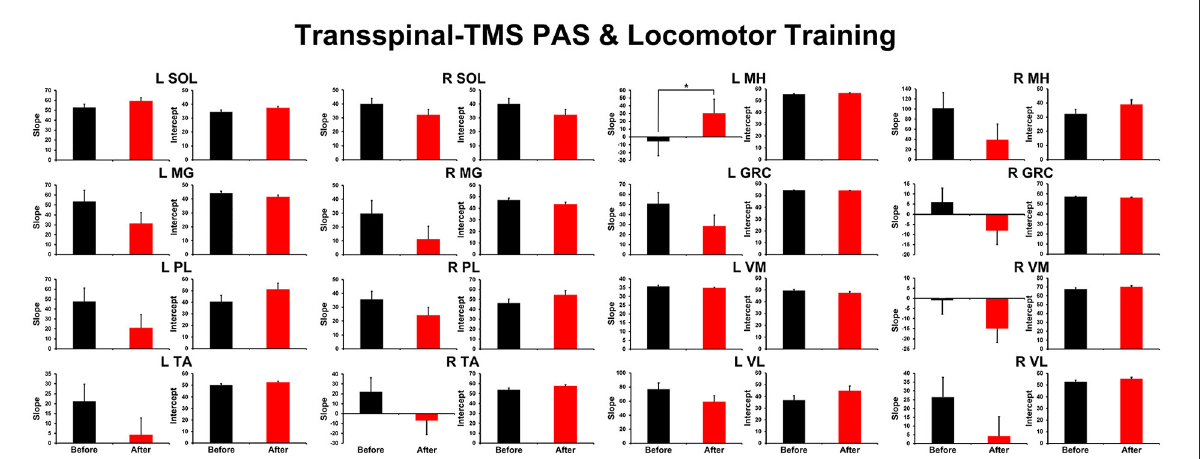
FIGURE2 Overall amplitude of slope and intercept for TEPs recorded from left and right leg muscles. For each subject and muscle, a linear regression was applied to the normalized TEP amplitude plotted against the homonymous background EMG activity before and after transspinal-TMS PAS and locomotor training. An asterisk indicates a significant difference before and after intervention. Error bars indicate the SEM. PAS, paired associative stimulation; TEPs, transspinal evoked potentials.